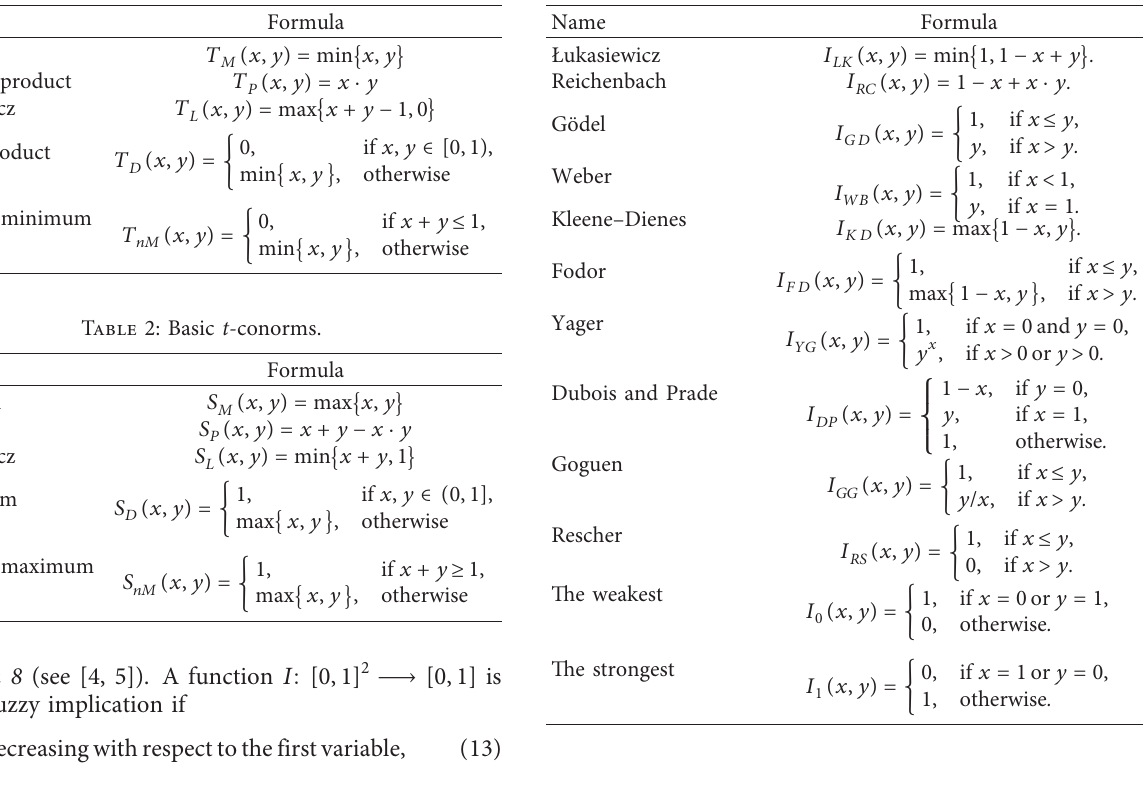
Table 1: Basic t -norms.